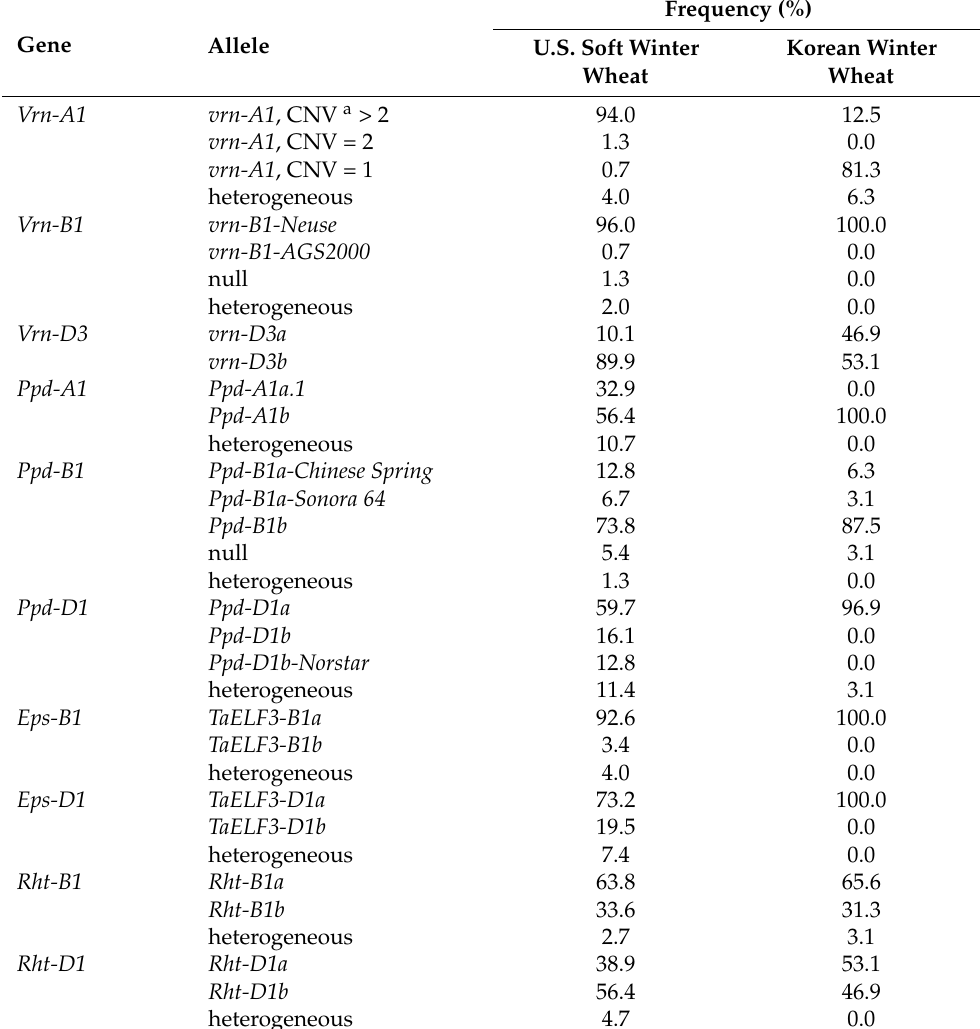
Table 1. Frequency of different alleles at the vernalization ( Vrn ), photoperiod ( Ppd ), earliness per se ( Eps ) and reduced-height ( Rht ) genes in 149 eastern U.S. soft winter wheat genotypes and 32 Korean winter wheat varieties.